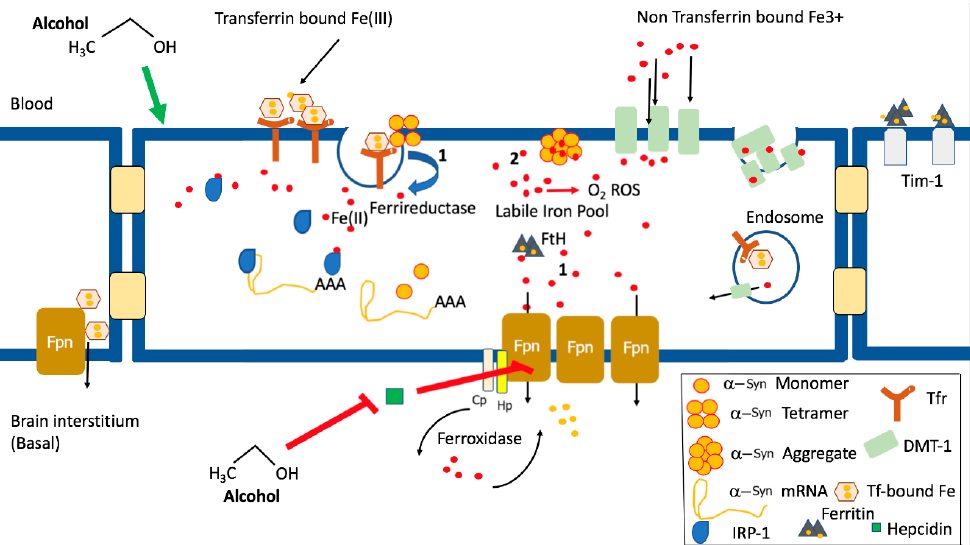
Figure 2. Uptake and export of iron from endothelial Cells of the blood–brain barrier are likely increased in alcohol use disorder, leading to brain iron dyshomeostasis. Alcohol misuse leads to systemic iron overload and to increased expression of α -synuclein. Recent evidence places apo- and holo-transferrin and Tim1 as central players in regulated iron loading at the blood–brain barrier (BBB). Ferritin is the primary storage form of iron in endothelial cells, and ferroportin is the main export pathway of iron across endothelial cells. (1) Alcohol reduces expression of the hormone hepcidin, leading to increases in the iron transport proteins DMT-1 and ferroportin, causing the build-up of the labile iron pool (LIP) Fe (II) and increased brain iron accumulation. (2) The mRNA of α -Syn has a uniquely configured iron responsive element (IRE) which binds to the translational repressor, iron regulatory protein 1 (IRP-1). Iron binding to the IRP removes it from the IRE, allowing the translation of α -Syn mRNA to proceed. (3) This leads to increases in α -Syn protein expression and increased functional α -Syn with intact ferriductase activity, leading to further increases in the LIP. (4) The resulting increase in α -Syn expression may lead to α -Syn aggregation and, in the absence of increased ferritin (FtH) for iron storage, increased oxidative stress and cell death. Iron homeostasis is achieved in part by post-transcriptional regulation through highly conserved messenger RNA (mRNA) stem loop motifs called iron response elements (IREs), which are present in the untranslated regions (UTRs) of a number of transcripts that are essential to iron metabolism. Iron response elements (IREs) are RNA stem loops in the UTRs of ferritin and transferrin-receptor mRNAs, where iron regulatory protein 1 and 2 (IRP1 and IRP2) bind to ferritin IREs to block their translation in Fe depletion and bind to TfR mRNAs and DMT-1 (iron import proteins) to stabilize their mRNAs [94,95]. In iron depletion, this mechanism enhances iron uptake into cells and stops it from being sequestered away for storage. IRP1 can therefore act as both a translational inhibitor and an enhancer to maintain iron homeostasis [96]. Our previous work reported a non canonical IRE in the 5’UTR of the Alzheimer’s disease (AD)-associated amyloid precursor protein (APP) 5’UTR. We used this target in high throughput screens (HTS) which led to the identification of several small molecules, including JTR-009 with APP and amyloid lowering efficacy [97,98]. We also identified a type 2 IRE in the 5’UTR of the α -Syn transcript, and this has been confirmed by others [84,85]. This IRE has been used as a therapeutic target for the identification of small molecules to specifically lower α -Syn expression [99]. Interestingly, although both β and γ -Syn show a high degree of homology to α -Syn at the protein sequence level, they do not contain IRE-like sequences within their respective mRNAs and do not prominently deposit with α -Syn in brain lesions, making the IRE on α -Syn a highly unique sequence and excellent therapeutic target. Our therapeutic strategy to limit α -Syn